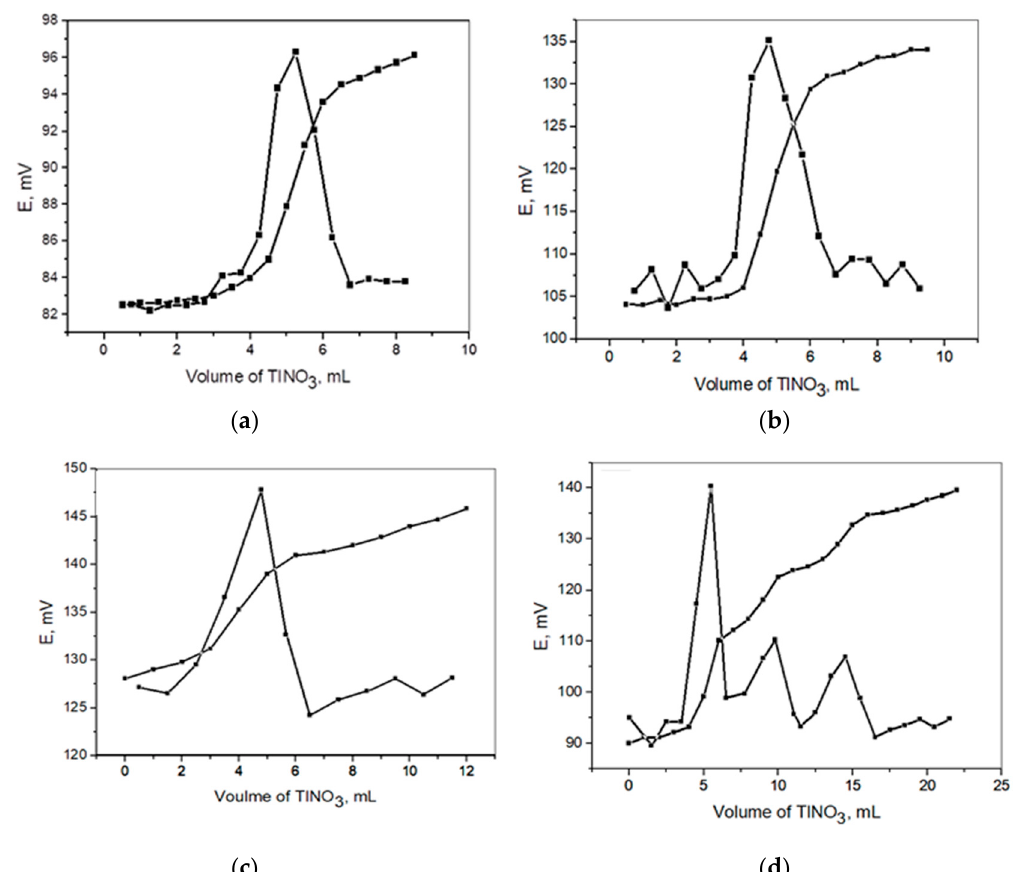
Figure 8. Potentiometric titration curves of NaI ( a ), Na 2 S ( b ), NaBr ( c ), and a mixture of them ( d ) in solution (50 mL) using 0.01 M TINO 3 titrant (i.e, subfigure represents the 1 st derivative for the titration).